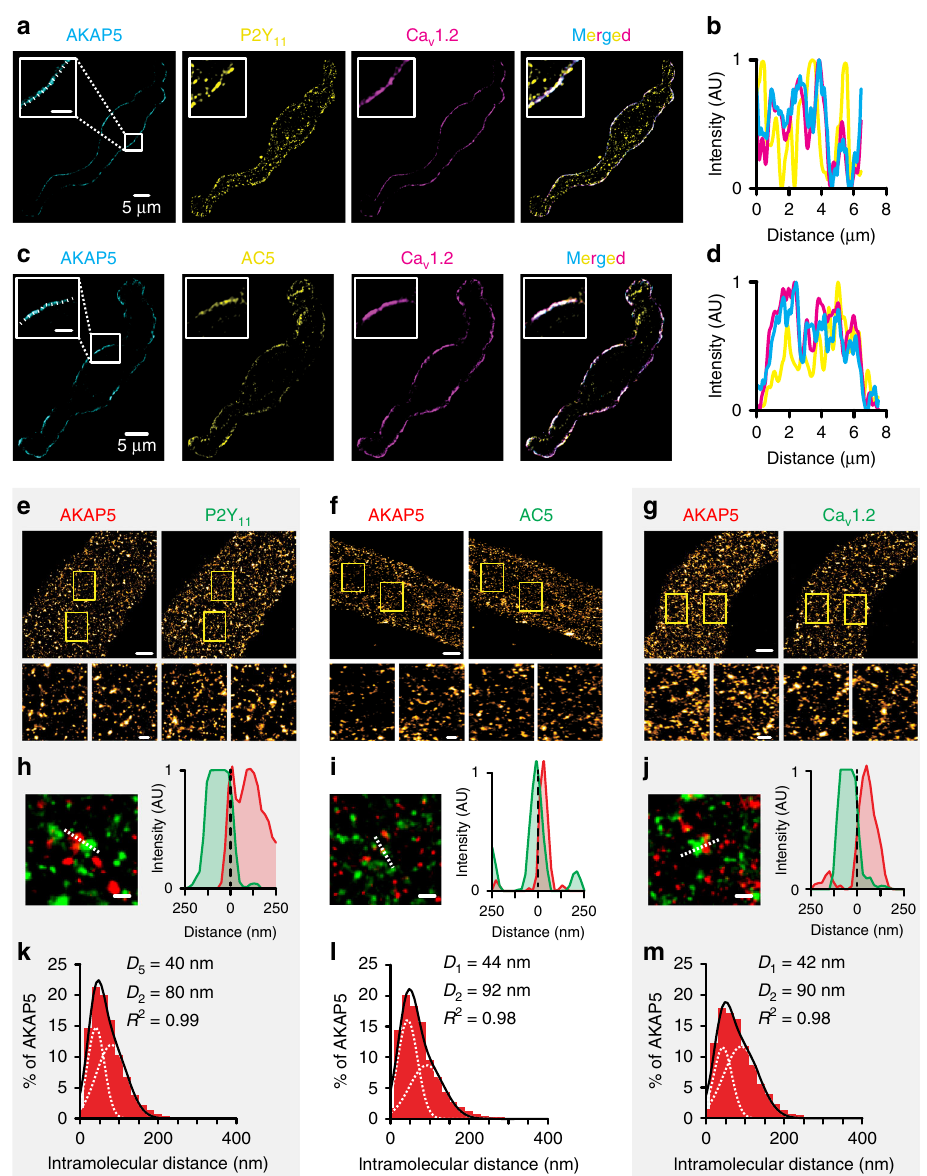
Fig. 5 AKAP5 closely associates with P2Y 11 -like, AC5, and Ca V 1.2. Representative super-resolution Airyscan intensity projection images and line intensity pro fi le of arterial myocytes triple-labeled for either a , b AKAP5 (cyan), P2Y 11 (yellow), and Ca V 1.2 (magenta) or c , d AKAP5 (cyan), AC5 (yellow), and Ca V 1.2 (magenta). Merged images are on the right side panels. The magni fi ed insets are from regions highlighted by the white squares in the AKAP5 images. Insets ’ scale bars = 2 μ m. Line intensity pro fi les obtained from the regions below the dotted lines in the magni fi ed insets in ( a ) and ( c ). Similar results were observed in six different cells from two independent preparations per condition. Representative super-resolution GSD reconstruction maps of arterial myocytes labeled for e AKAP5 and P2Y 11 , f AKAP5 and AC5, or g AKAP5 and Ca V 1.2 (scale bar = 2 µ m). Two magni fi ed areas obtained from the region highlighted by the yellow boxes in the main fi gure are shown (scale bar = 200 nm). These magni fi ed panels are intended to provide a clearer view of cluster size and distribution in two areas of a cell. Enlarged merged images (left) and associated x – y fl uorescence intensity pro fi le (right) from the areas highlighted by the dotted lines of areas of close proximity between h AKAP5 and P2Y 11 , i AKAP5 and AC5, or j AKAP5 and Ca V 1.2 (scale bar = 200 nm). Histograms of the lowest intermolecular distance to AKAP5 centroids for k P2Y 11 ( n = 11,778 particles from 4 cells/2 WT mice), l AC5 ( n = 10,049 particles from 5 cells/2 WT mice), or m Ca V 1.2 ( n = 14,750 particles from 5 cells/2 WT mice) fl uorescence particles. Data were fi t with a sum of two Gaussian functions with depicted centroids and R 2 . Source data are provided as Source data fi and Ca V 1.2 form a nanocomplex in human arterial myocytes that complex containing AKAP5, a purinergic receptor and AC5 in excitable cells. PLA signal was not observed when only one primary is consistent between sexes. antibody was present (Supplementary Fig. 7b, c). Together with A similar association pattern was observed in WT mouse prior studies showing a close association between PKA/Ca V 1.2, arterial myocytes. PLA signals were detected in cells co-labeled P2Y 11 /Ca V 1.2, and P2Y 11 /PKA in human male and female arterial for P2Y 11 -Ca V 1.2, P2Y 11 -PKA cat , P2Y 11 -AKAP5, Ca V 1.2-AKAP5, myocytes 12,20 , these results suggest that AKAP5, P2Y 11 , AC5, PKA, AC5-AKAP5, AC5-P2Y 11 , AC5-PKA cat , and Ca V 1.2-PKA RII α